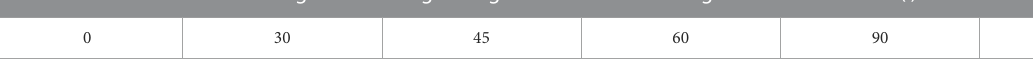
TABLE 3 Different angle θ . Angle between grinding direction and feeding direction of belt θ ( ° )